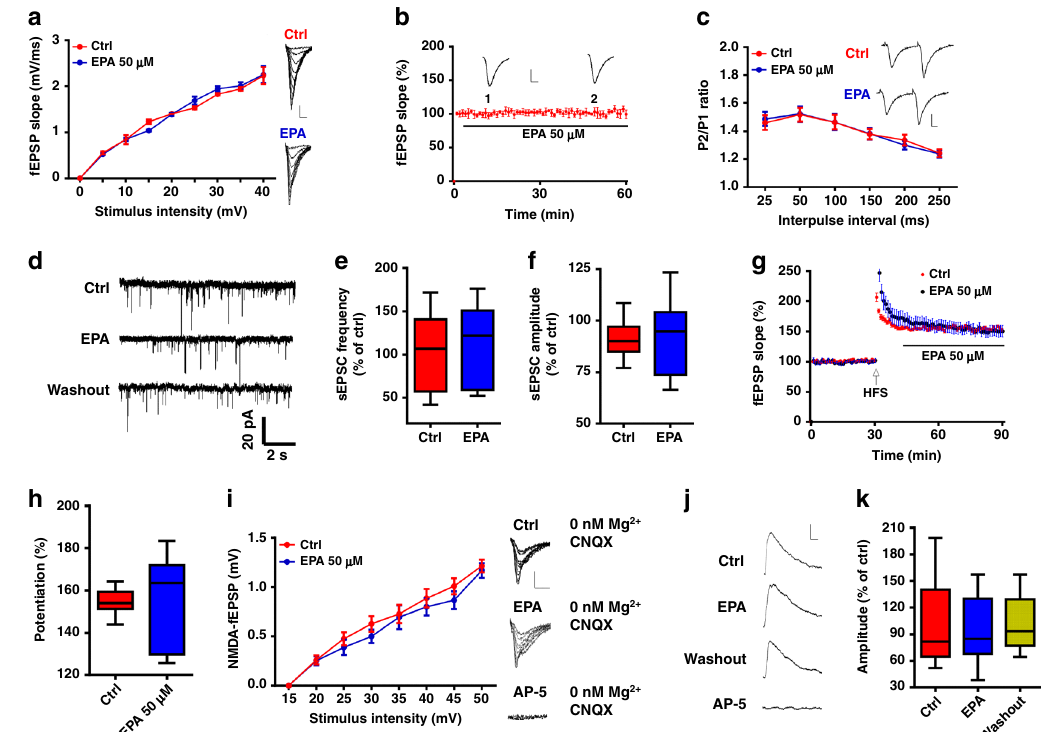
Fig. 3 No effect of acute EPA (50 μ M) treatment on glutamatergic transmission in hippocampal slices. a I – O curves after acute EPA treatment ( n = 6 slices/group; repeated measures two-way ANOVA, F (1, 90) = 18.367, P = 0.837). b Bath application of EPA after establishing the baseline recording did not affect the fEPSP slope ( n = 5slices). c PPF after EPA treatment ( n = 6 slices/group; repeated measures two-way ANOVA, F (1, 60) = 23.453, P = 0.812); (right) representative recordings. Scale bars: 0.5 mV, 5 ms. d – f Effect of EPA on sEPSCs frequency ( e , n = 9 slices, two-tailed Student ’ s t -test, P = 0.758) and amplitude ( f , two-tailed Student ’ s t -test, P = 0.938). g , h Effect of EPA treatment on the LTP expression ( n = 7 – 11 slices/group; two-tailed Student ’ s t